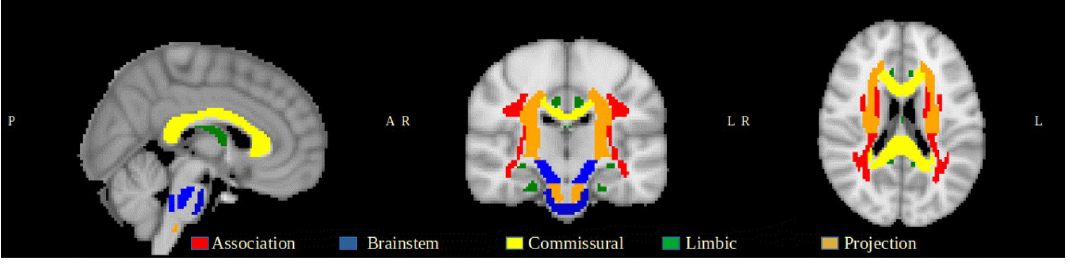
Figure 1. White matter tract